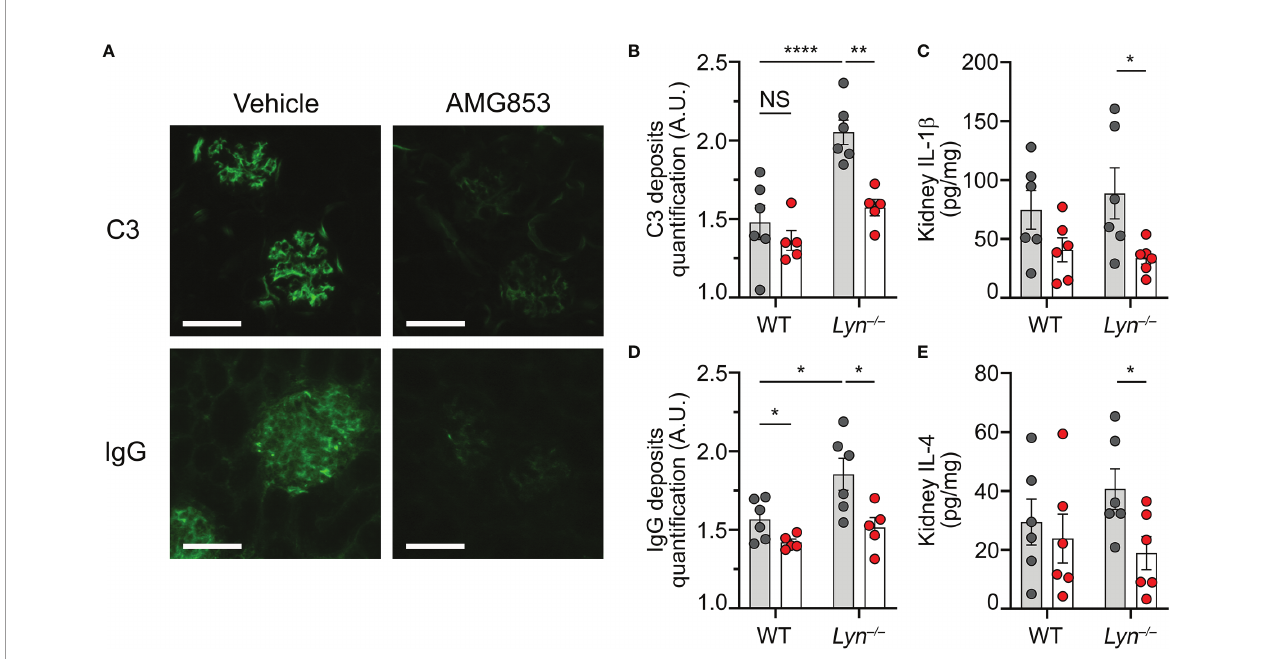
FIGURE 4 | AMG853 dampens lupus-like nephritis in Lyn − / − mice. Aged (40 – 50 weeks) wild-type (WT) and Lyn − / − mice were treated daily for 10 days by oral gavage with AMG853 ( n = 5 – 6 per genotype, red fi lled circles ) or vehicle (10% EtOH in tap water; n = 6 per genotype, gray fi lled circles ). (A – C) Cryosections of kidneys (4 µm) analyzed by immuno fl uorescence for C3 and IgG staining as exempli fi ed for Lyn − / − mice in (A) ( scale bar = 60 µm) and quanti fi ed in (B, C) as arbitrary units (a.u.) corresponding to the ratio of glomerular measured fl uorescence intensity to the interstitial background fl uorescence intensity. (D, E) Protein extracts from kidneys assessed for total protein and cytokine contents by bicinchoninic acid (BCA) assay and ELISA, respectively, as described in Materials and methods . (D, E) Content of IL-1 b (D) or IL-4 (E) in kidney extracts expressed in picograms per milligram of renal proteins. (B – E) Results from three independent experiments presented as individual values in bars representing the mean ± SEM. Statistical analyses used unpaired Student ’ s t -tests between the indicated groups. NS p > 0.05; * p < 0.05; ** p < 0.01; **** p <